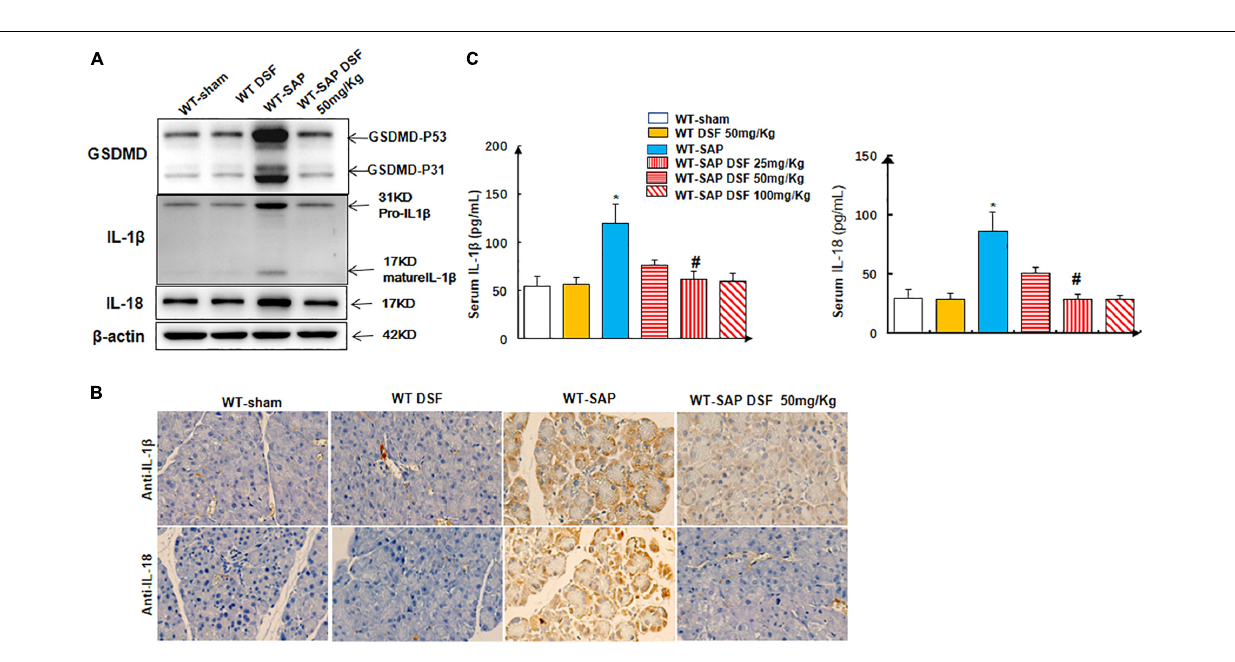
FIGURE 5 | DSF inhibits the cleavage of GSDMD and decreases the levels of IL-1 β and IL-18 in pancreatic tissues. WT-sham and WT-SAP mouse models were treated with DSF (50 mg/kg). The mice were sacrificed 24 h after LPS injection. (A,B) Western blotting and IHC analysis of GSDMD, IL-1 β , and IL-18 in pancreatic tissue. Scale bars, × 200. (C) Serum IL-1 β and IL-18 were analyzed by ELISA. Experiments were repeated three times. Data are presented as mean ± SD ( n = 10 per group). *p < 0.05 vs. other groups; # p < 0.05 vs. WT-SAP group, WT-SAP DSF (25 mg/kg); # p > 0.05 vs. sham + sham DSF (50 mg/kg), WT-SAP DSF (100 mg/kg). DSF, disulfiram; GSDMD, gasdermin D; WT, wild type; SAP, severe acute pancreatitis; LPS, lipopolysaccharide; IHC,